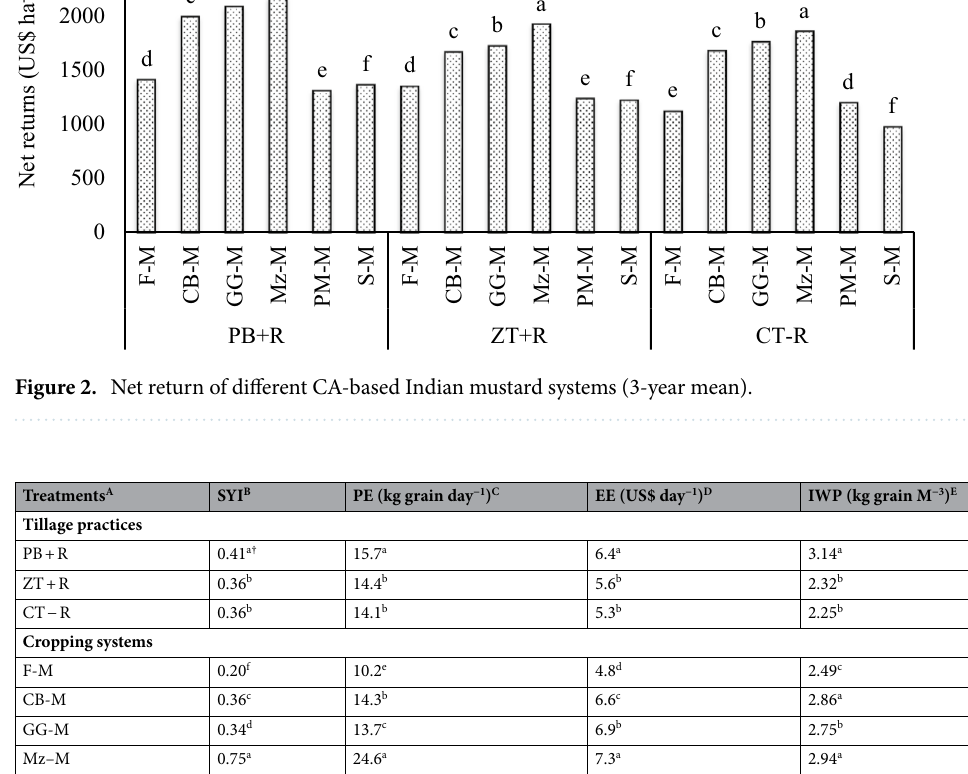
Table 3. Sustainability, production and economic efficiency, and water productivity under different CA-based Indian mustard systems (mean of 3 years). † Means followed by a similar lowercase letters within a column are not significantly different at 0.05 level of probability using DMRT. A Refer Table 7 for treatment description. B Sustainable yield index. C Production efficiency. D Economic efficiency. E Irrigation water productivity.